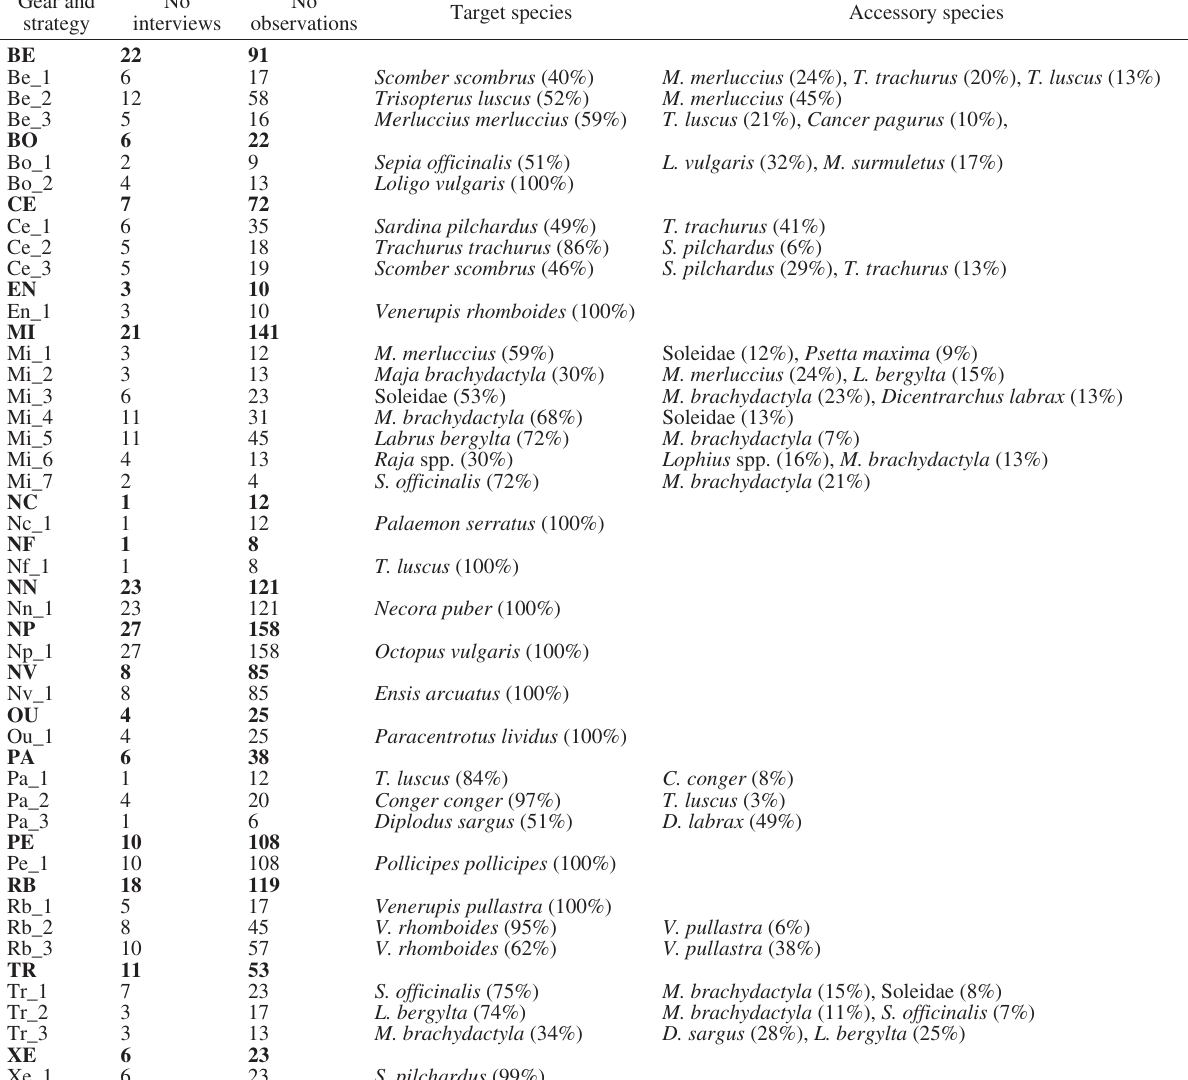
Table 2. – Catch profiles of the fishing strategies used in the Cíes Islands. The percentage of the catches is shown in brackets. The number of interviews and the number of observations (each observation is the strategy used per month and boat) with information about the different strategies are indicated. Gear and